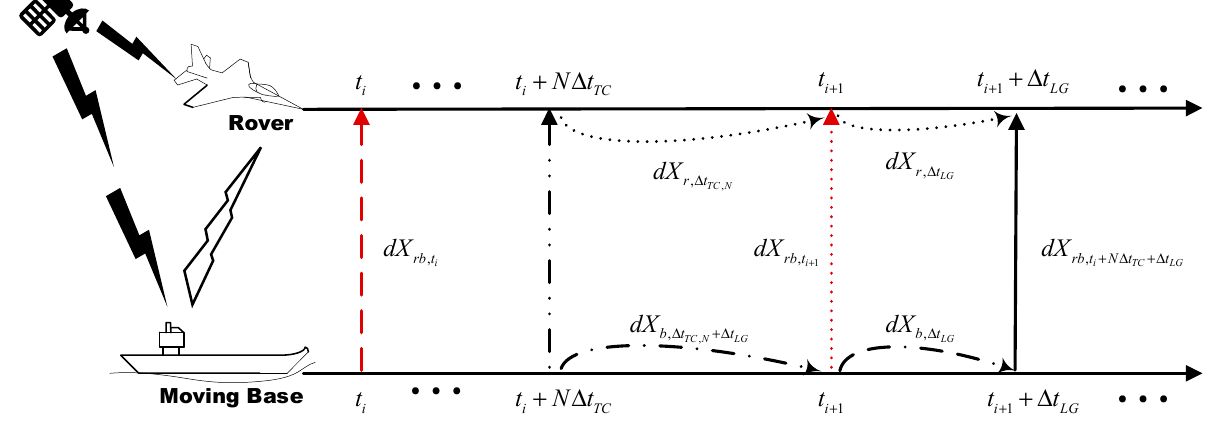
Figure 4. Integration mechanism in the presence of latency of raw GNSS observations. Last but not least, we note that the proposed method also shows benefits in